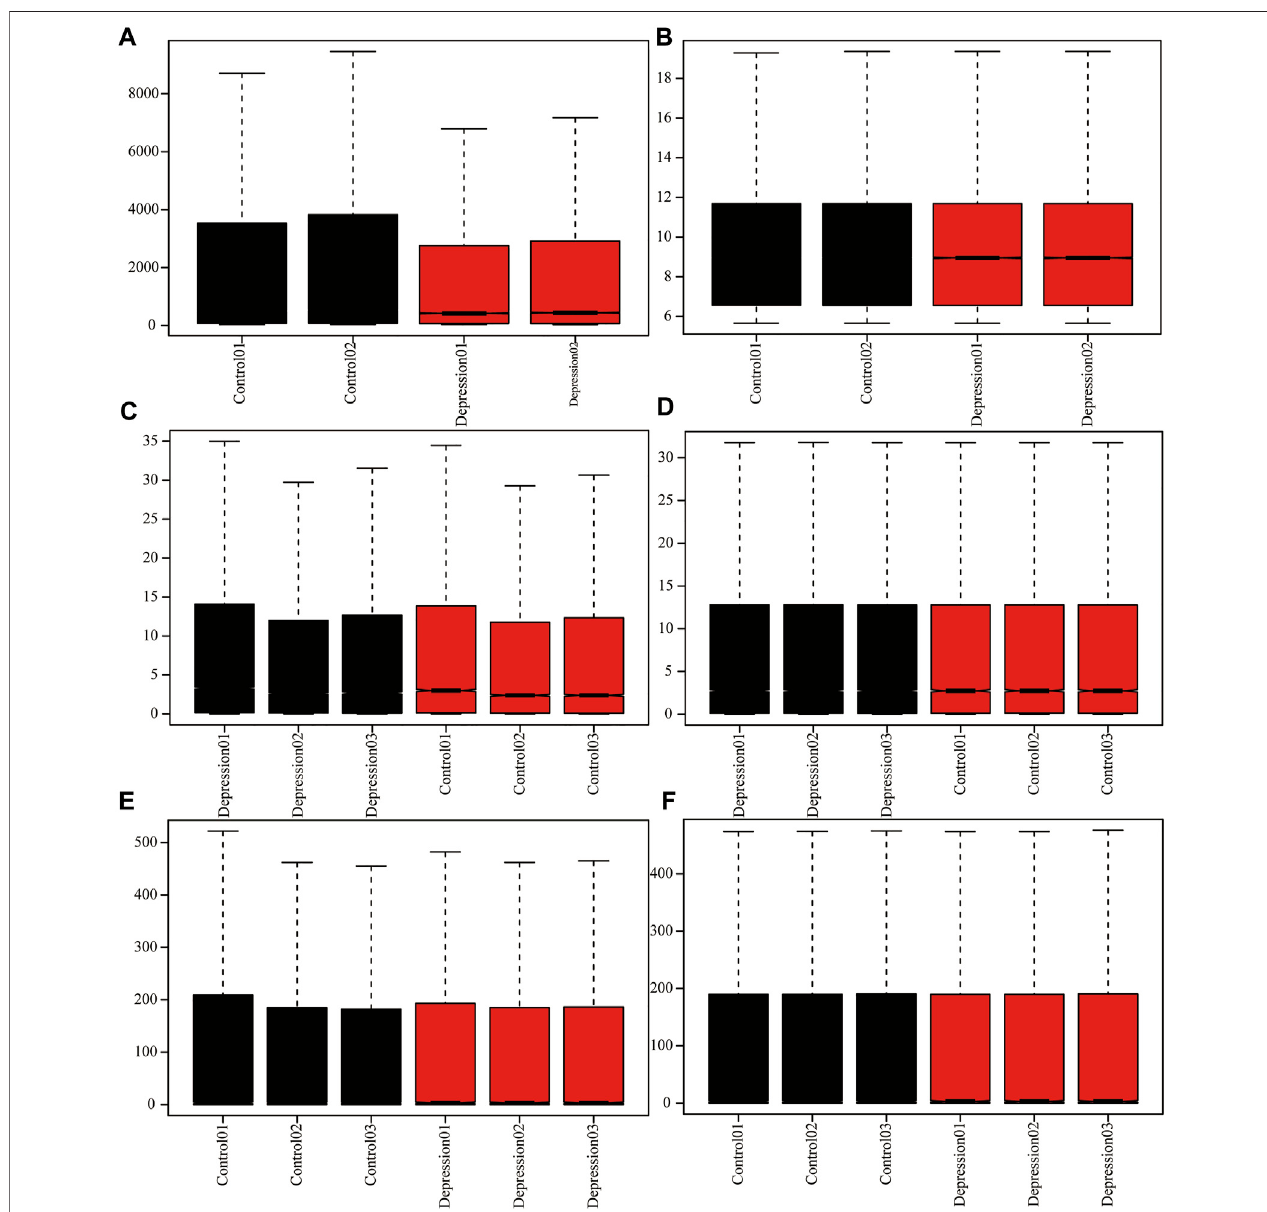
FIGURE 2 | Adjusted for depression data. (A,B) : GSE63377 chip data before and after background correction. (C,D) : GSE124387 chip data before and after correction. (E,F) : GSE86392 gene chip data before and after